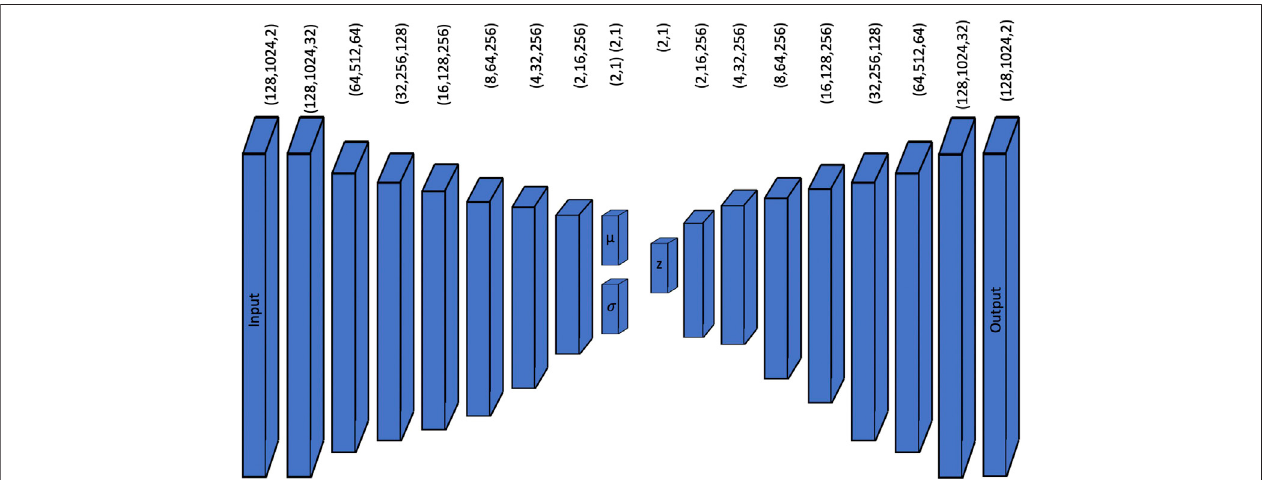
FIGURE 1 | Architecture of our VAE model for chord synthesis for the case L (cid:1) 2. The encoder takes a (128,1024,2) MFCC image and passes it through several downsampling layers until it compacts the data into a low-dimension latent space z . The decoding process samples the latent vector using a Gaussian distribution of mean μ and standard deviation σ , and passes it through several upsampling layers until a (128,1024,2) output is obtained that is later converted to an audio